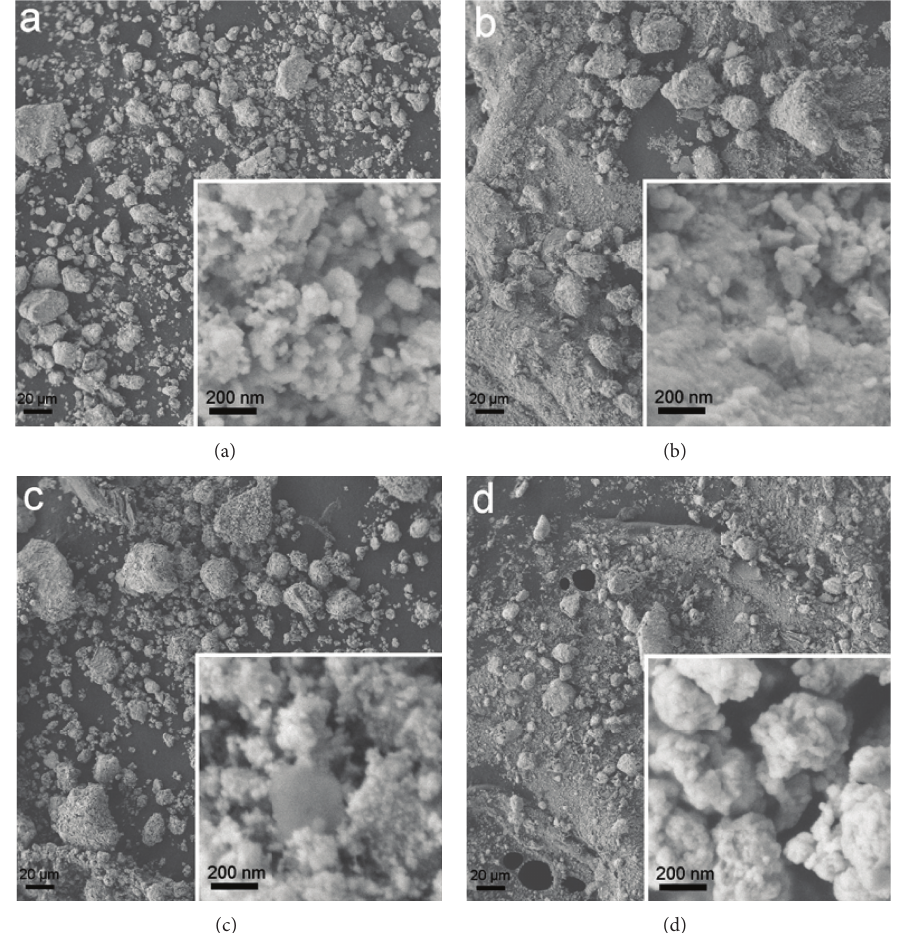
Figure 1: SEM images of Zuota samples ( × 300). (a) S1; (b) S2; (c) S3; (d) S4. The sects were images of higher magnification ( × 50,000).